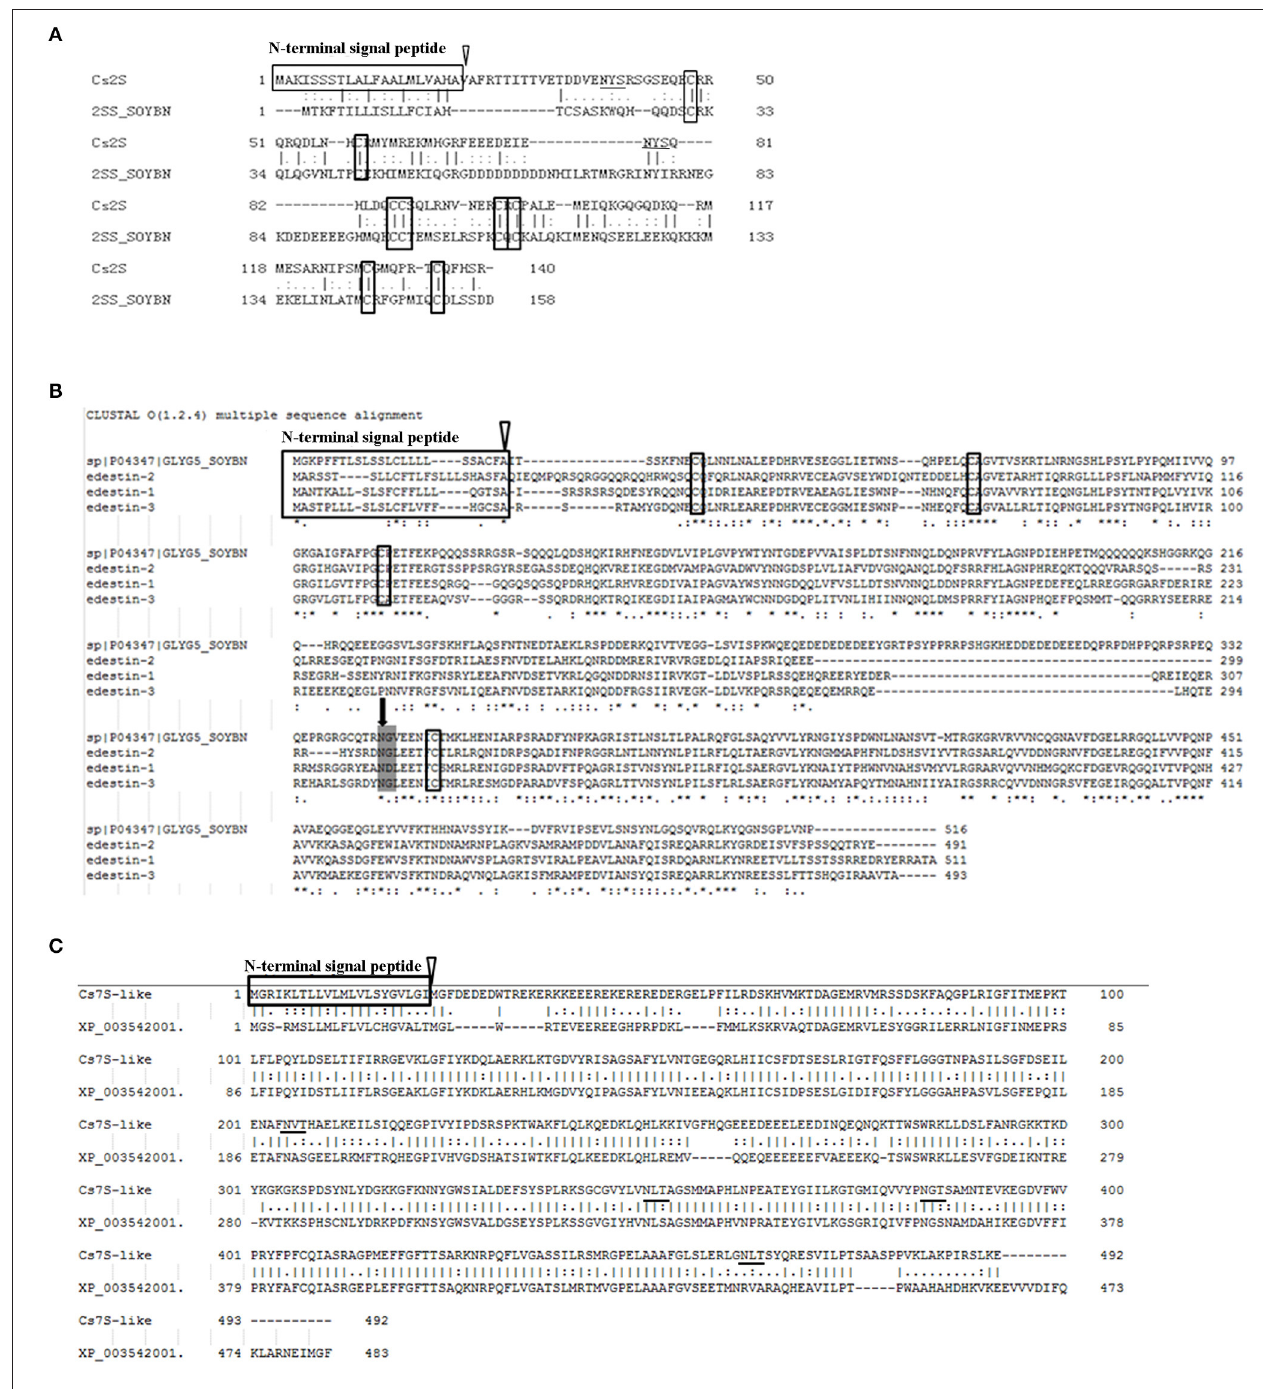
FIGURE 5 | Alignment results of the coding sequences. (A) Alignment result for Cs2S and soybean 2S albumin. (B) Alignment results for the three Edestins and soybean 11S globulin. Broken lines were introduced to maximize similarity. Asterisks indicate identical amino acids. (C) Alignment result of Cs7S and soybean 7S vicilin-like protein (XP_003542001). The cleavage site of signal peptide is indicated by open triangle, while the conserved cysteine residues are boxed. The black arrows indicate cleavage site for splitting these polypeptides into an acidic subunit and a basic subunit. The underlines indicate the predicted glycosylation sites. which reported that AS was 34.0 kDa, while BS were 20.0